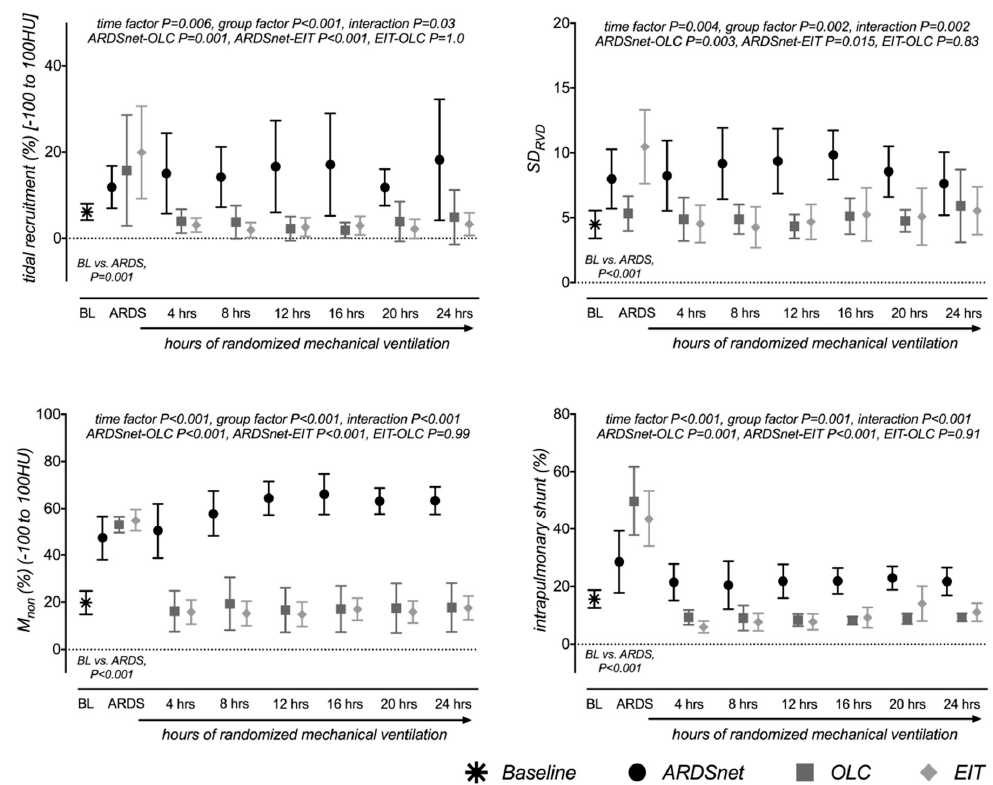
Figure 2. Surrogates of tidal recruitment and lung collapse. Measurements were performed at baseline (BL), ARDS/randomization (ARDS) and every 4 h for 24 h for the three ventilation groups ARDSnet, Open Lung Concept (OLC) and Electrical Impedance Tomography (EIT). Percentage of nonaerated lung tissue mass (M non ), tidal recruitment (TR), and intrapulmonary shunt are shown in percent. Temporal changes in the standard deviation of regional ventilation delay (SD RVD ) are shown as surrogates of inhomogeneous lung ventilation. Data are shown as means and their 95% confidence interval. Significant increases, especially in intrapulmonary shunt and M non , were shown between BL and ARDS for all parameters (paired t-test). Time and group effects and their interaction were tested using the general linear model approach. Differences between ventilation groups were tested by Sidak’s post-hoc test.